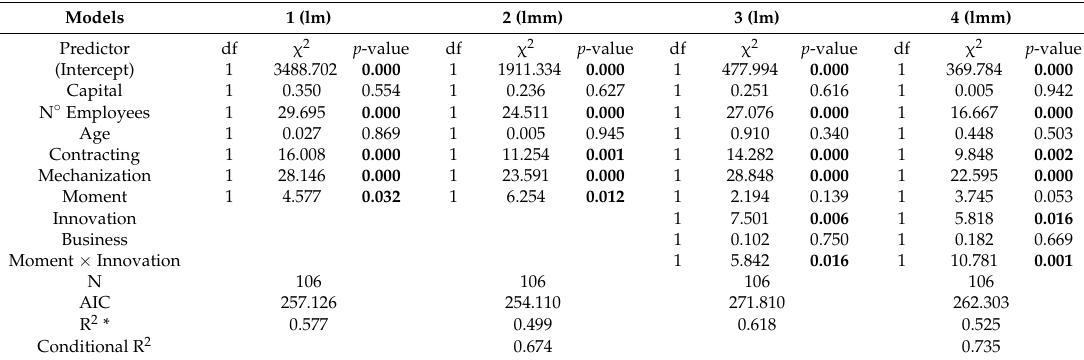
Table 2. Results of the linear and mixed linear effect models for production (t/month) of contractors during the study